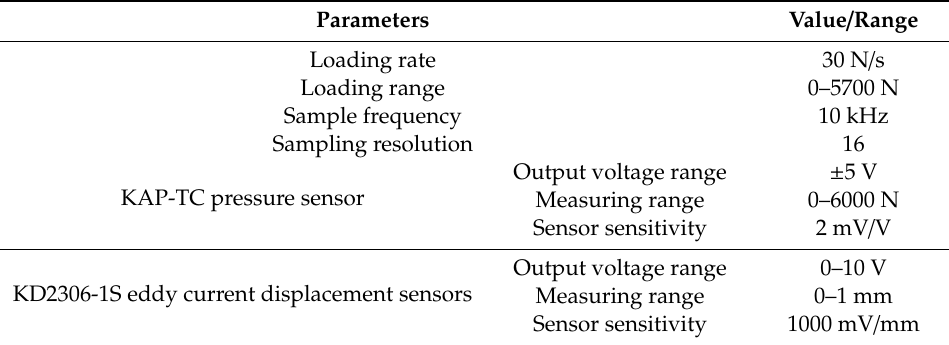
Table 3. The main parameters of experimental